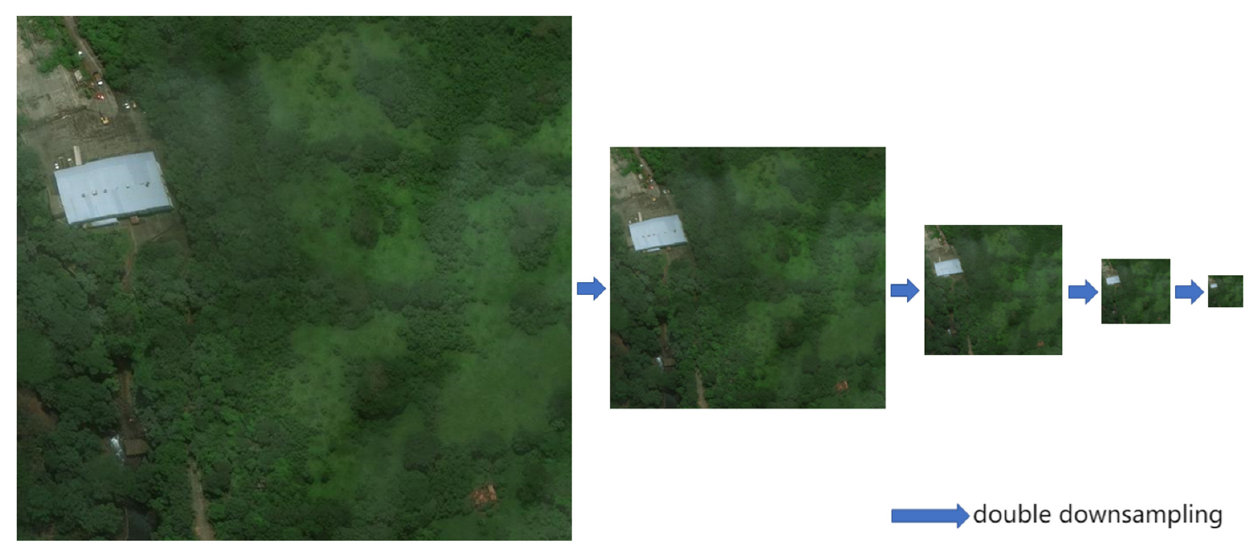
Figure 9. Downsampling the original resolution images in the xBD dataset.